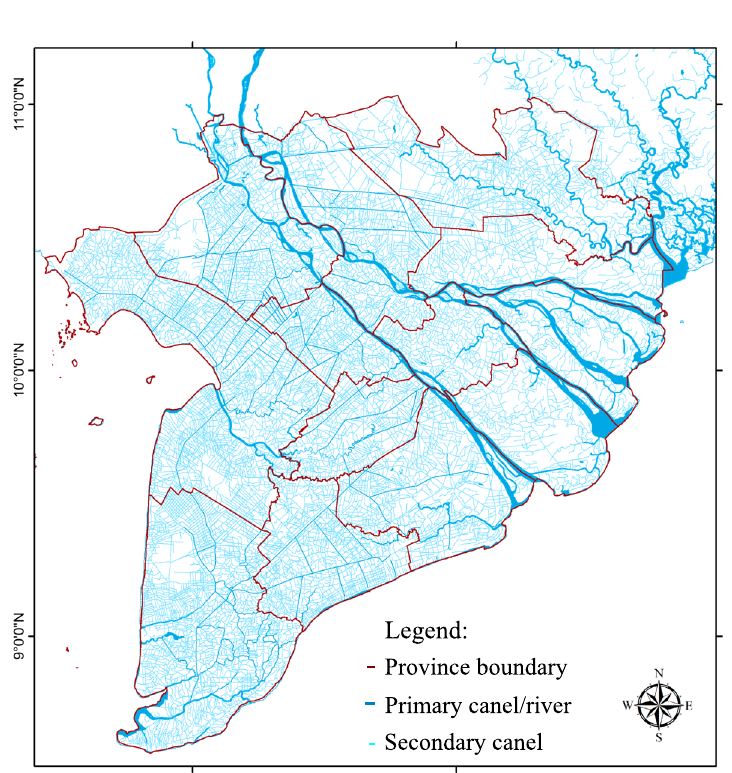
Fig. 6 River system and cannel networks in